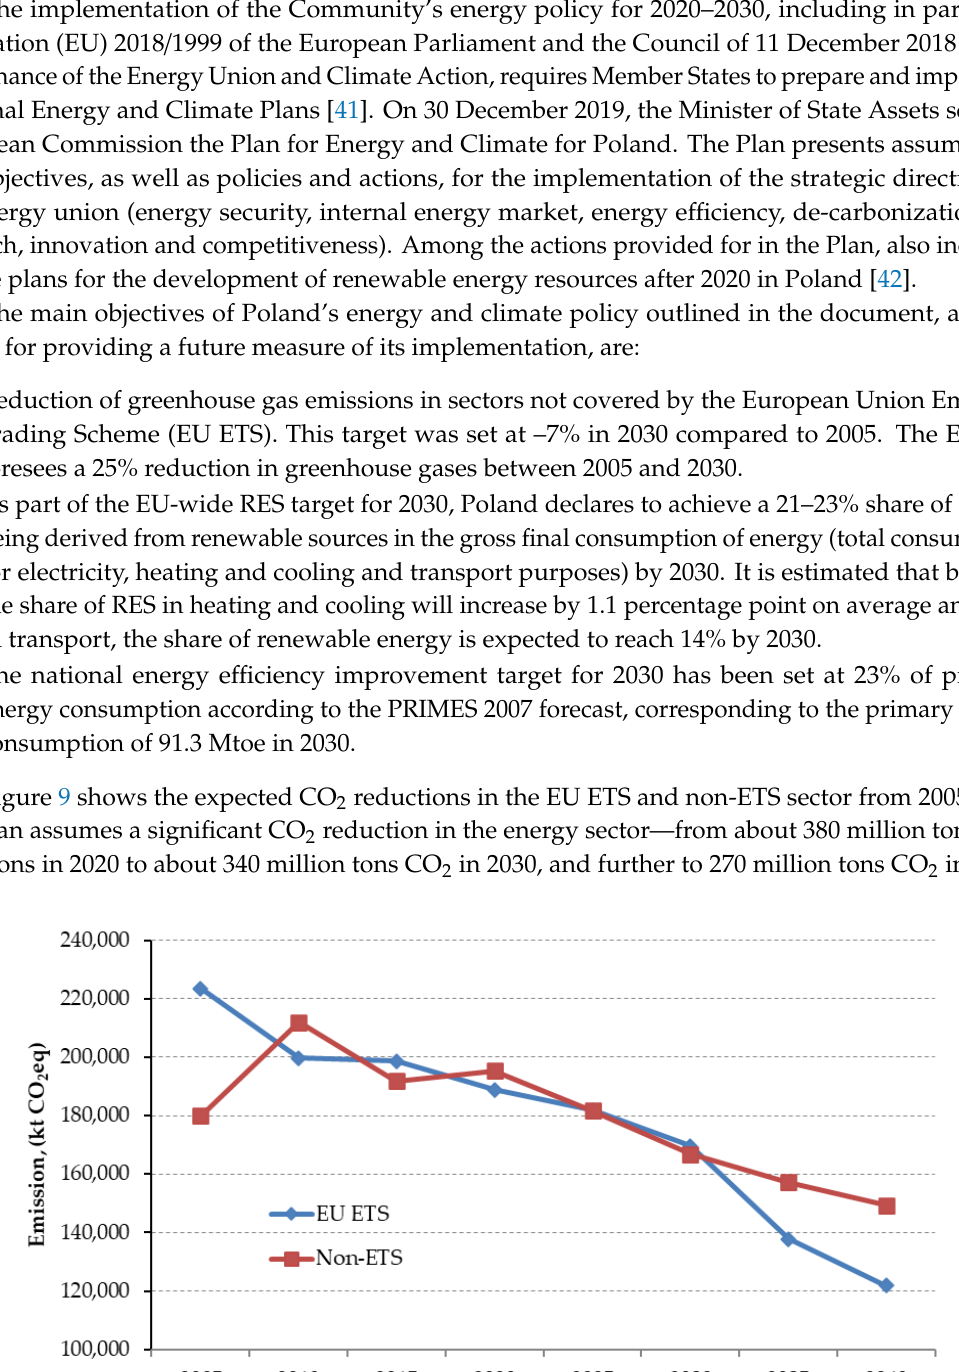
Table 10. Proposal of trajectory of renewable energy according to the National Energy and Climate Plan [42].